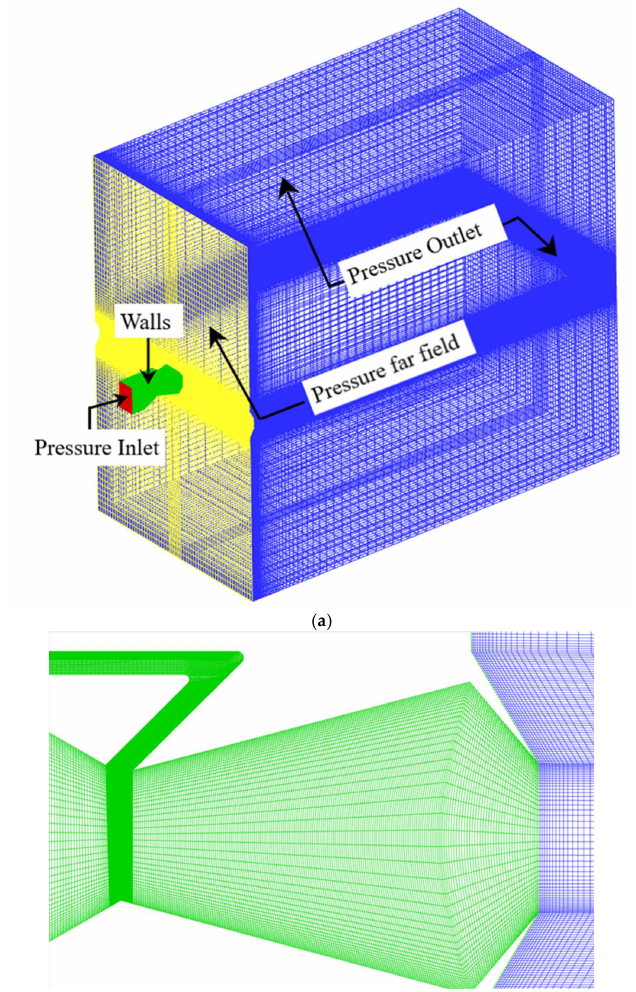
Figure 2. ( a ) Computational domain and boundary conditions ( b ) The mesh on the rectangular noz- zle.